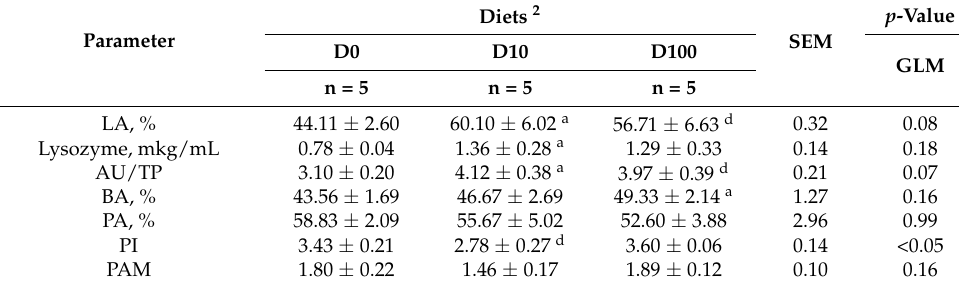
Table 9. Indicators of nonspecific resistance of experimental animals 1